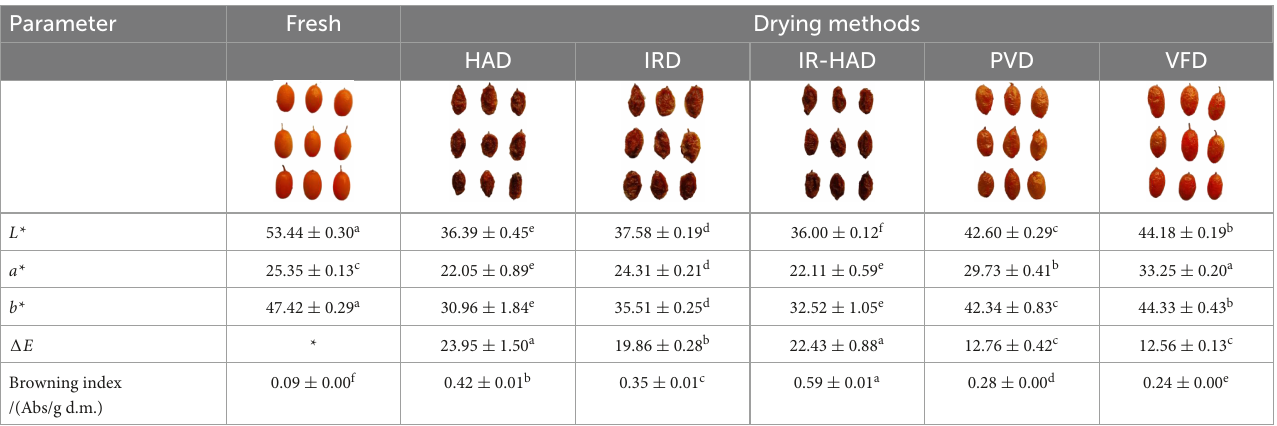
TABLE 1 The color parameters of sea buckthorn under different drying methods.